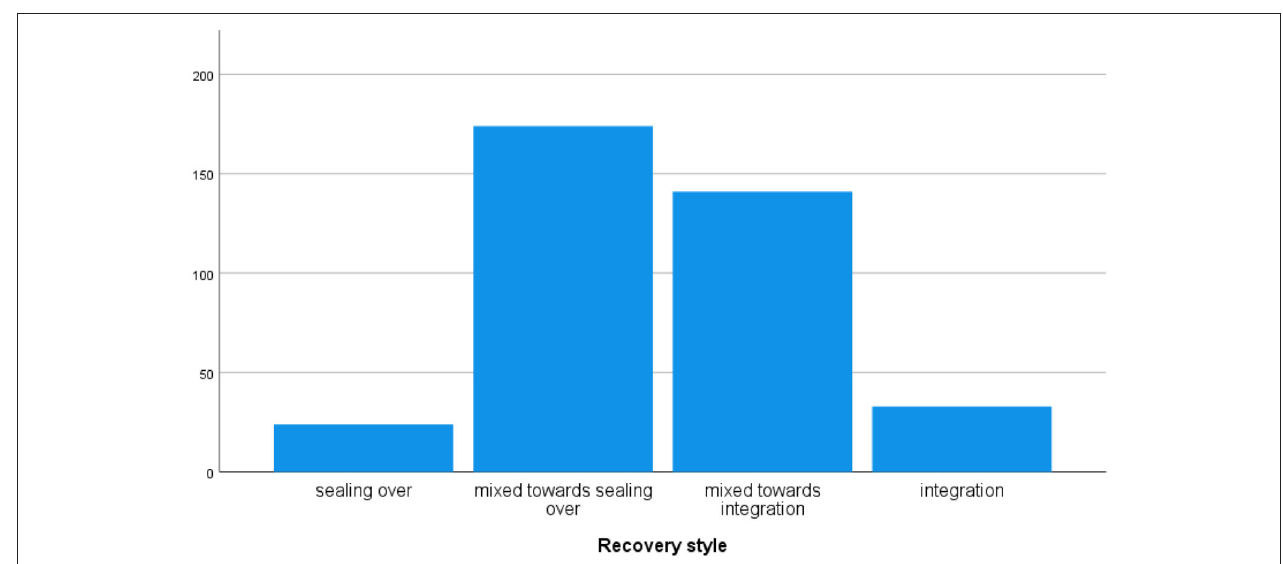
FIGURE 1 | Recovery style in the global sample.